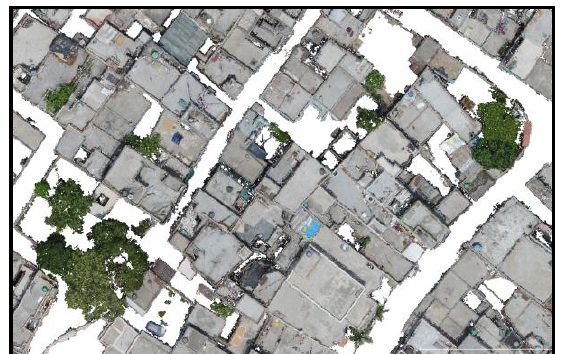
Figure 5: Non-ground points